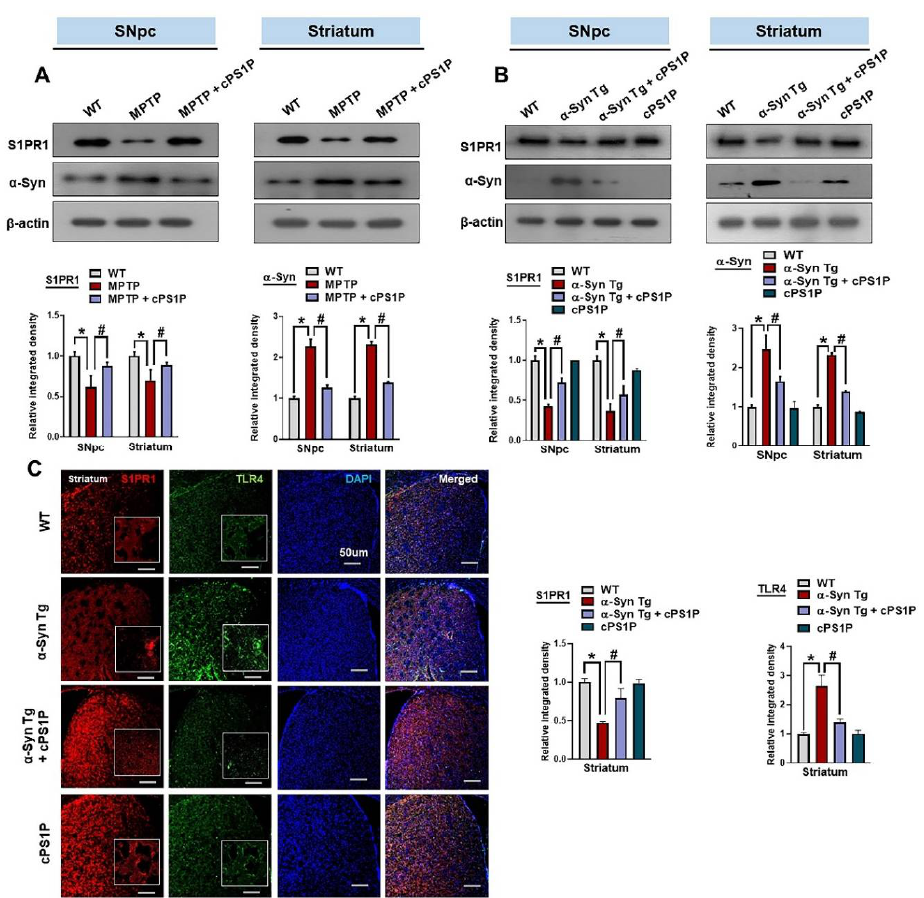
Figure 3. Effects of cPS1P against S1PR1 and α -synuclein in the MPTP and NSE-h α Syn PD mouse models. ( A ) Expression of S1PR1 and α -synuclein in the substantia nigra pars compacta